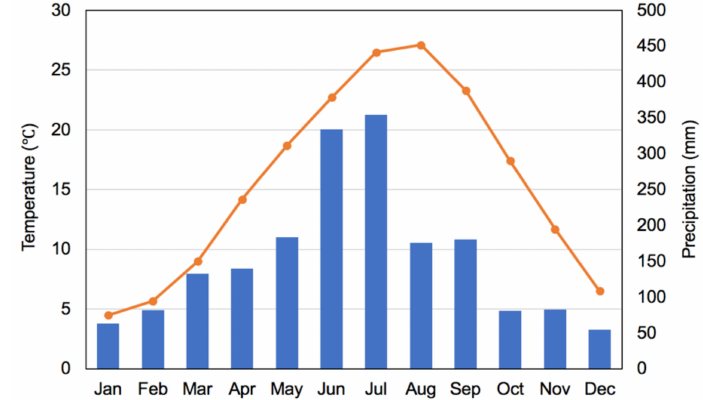
Figure 2. Monthly mean temperature (filled circles and lines) and monthly precipitation (bars) at Asakura station (N 33 ◦ 24.4 (cid:48) , E 130 ◦ 41.7 (cid:48) , 38m ASL), Fukuoka, Japan. These are 30 year mean values (from 1981 to